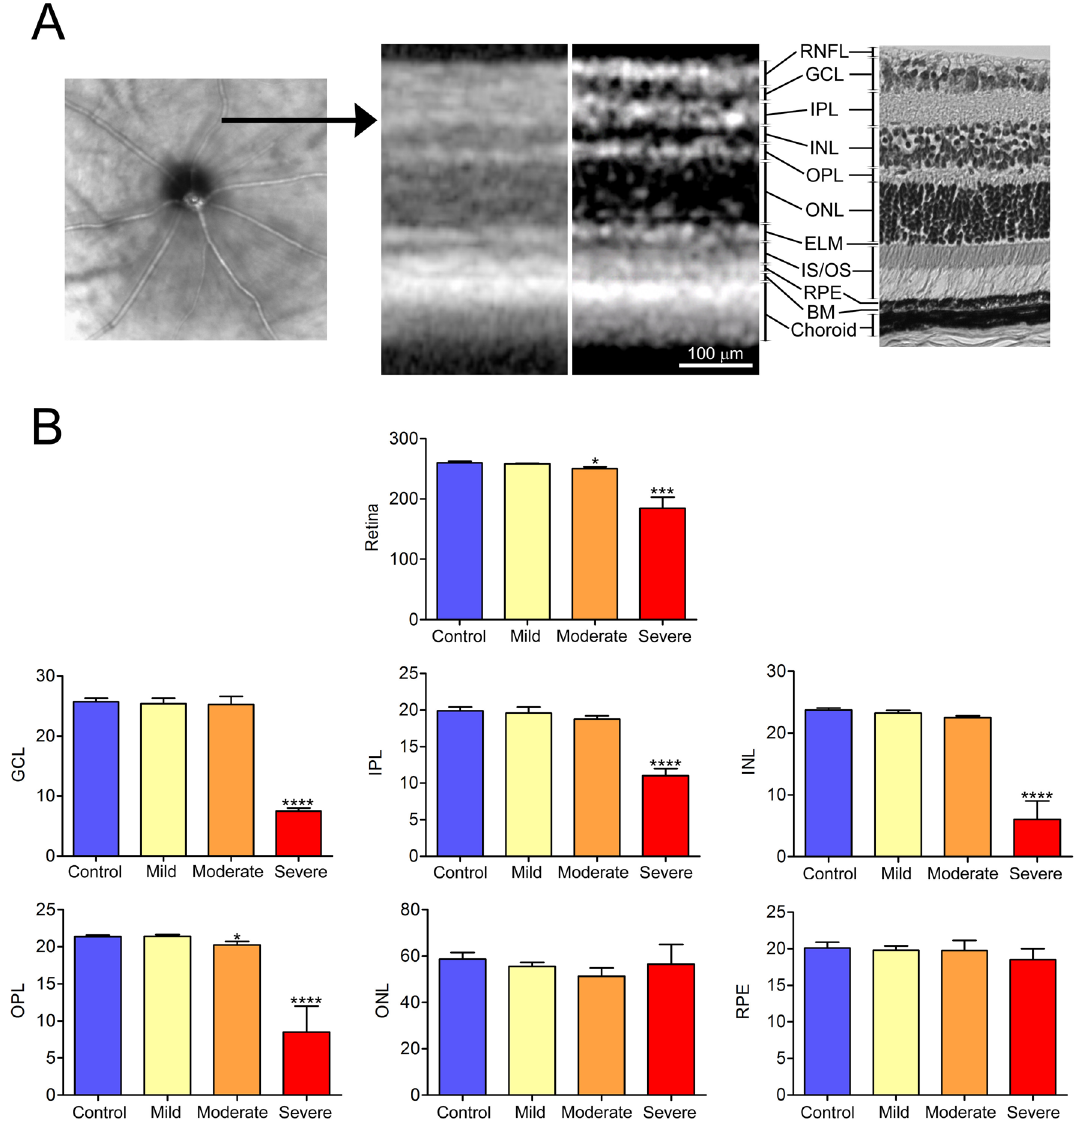
Figure 2. Retinal thinning with preservation of outer retinal layers in the juvenile mouse after exposure to HI conditions. ( A ) Original OCT image from control retina (left) with the horizontal black arrow on the superior side of the retina, pointing to the location of the cross-sectional OCT image (second from the left). The same cross-sectional OCT image was color-contrast modified and presented next to a photomicrograph of normal mouse retina. Eleven retinal layers were identified and marked besides the two images. ( B ) Automated segmentation was used to measure the full thickness of the retina along with GCL, IPL, INL, OPL, ONL and RPE layers using a proprietary software algorithm. The measurements were taken from scans acquired from the superior retina of right (control) and left (HI injured) eyes of 11 animals revealed evidence of significant retinal thinning with preservation of outer retinal layers in eyes with moderate and severe HI injury. Data presented as mean ± SD. *p < 0.05, ***p < 0.001, ****p < 0.0001. Scale bar = 100 μm. RNFL retinal nerve fiber layer, GCL ganglion cell layer, IPL inner plexiform layer, INL inner nuclear layer, OPL outer plexiform layer, ONL outer nuclear layer, ELM the external limiting membrane, IS/OS inner segment and outer segment of the photoreceptors, RPE retinal pigment epithelium, BM basement membrane; and the